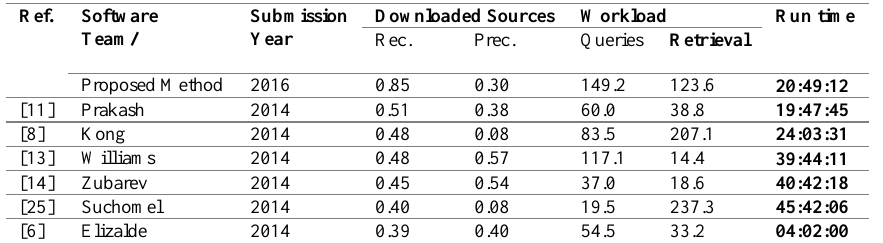
Run time Workload Downloaded Sources Submission